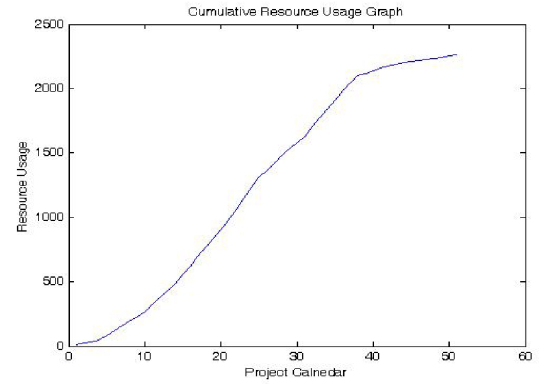
Figure 37. Cumulative resource usage for resource 1 of experiment 3 (after using forward